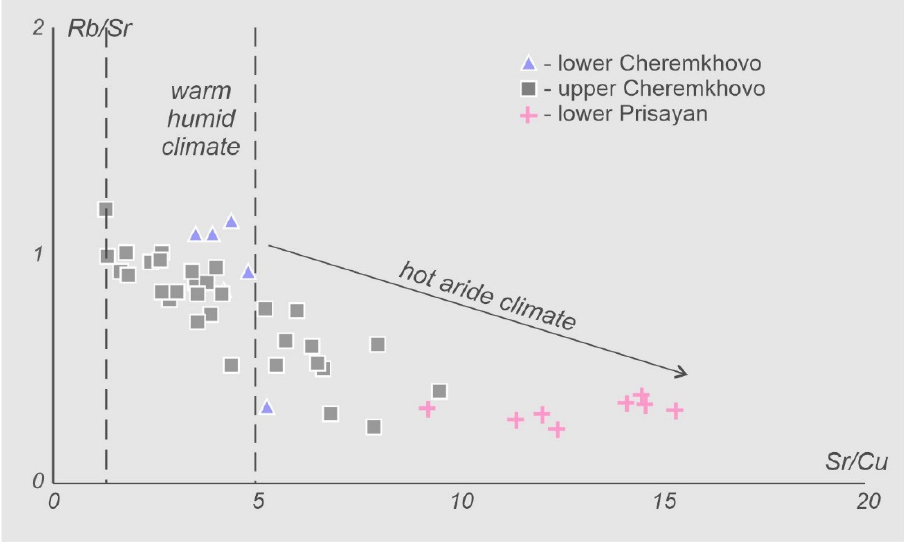
Figure 11. Sr/Cu versus Rb/Sr plot. The trends of Sr/Cu and Rb/Sr ratios are from [43,44] .